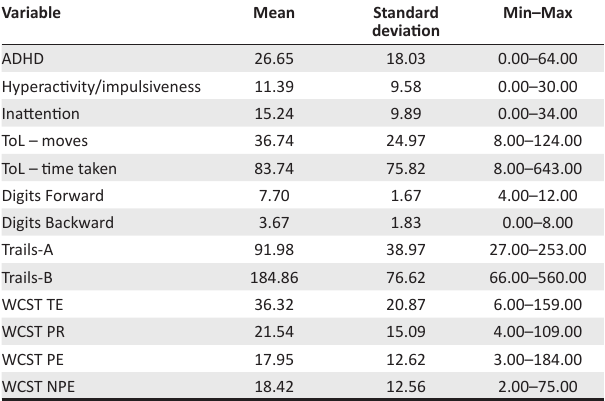
TABLE 1: Attention-deficit/hyperactivity disorder and executive function test results ( N =